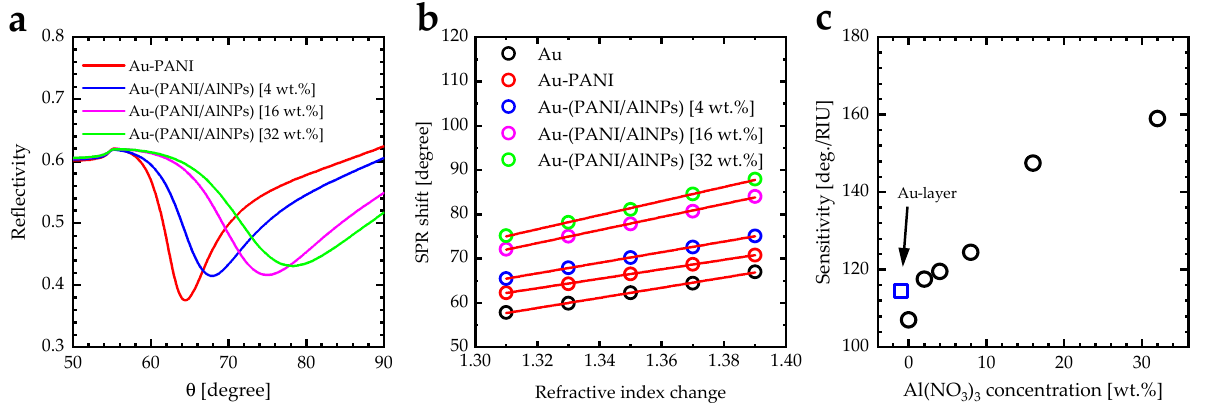
Figure 11. ( a ) SPR reflectivity curve for Kretschmann configuration of the prism-gold-(PANI- HCl)/Al(NO 3 ) 3 systems for selected Al(NO 3 ) 3 content [wt.%], ( b ) SPR angle shift versus the refractive index change of selected Al(NO 3 ) 3 content [wt.%], and ( c ) Sensitivity variation as a function of Al(NO 3 ) 3 concentration [wt.%] of prism-gold-(PANI-HCl)/Al(NO 3 ) 3 system. Table 2. Optical constant values, SPR angle, and SPR sensitivity of the gold film, and (PANI- HCl)/Al(NO 3 ) 3 complex composite film for different Al(NO 3 ) 3 concentrations at a wavelength of 685 nm.